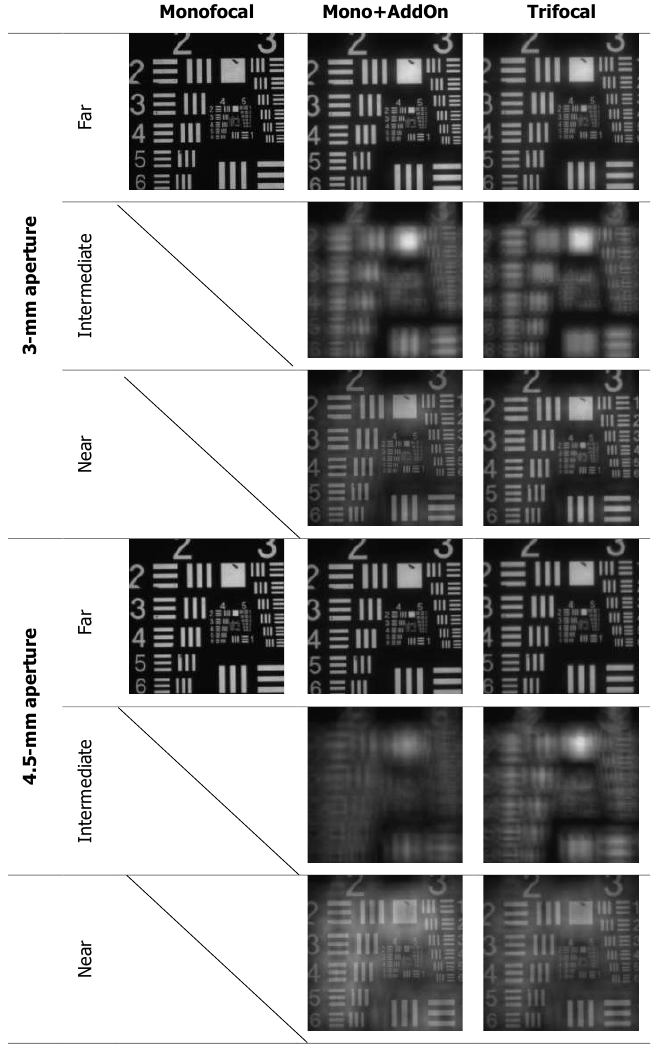
Figure 4. USAF target images recorded at the far, intermediate and near focus and apertures 3 mm and 4.5 mm.